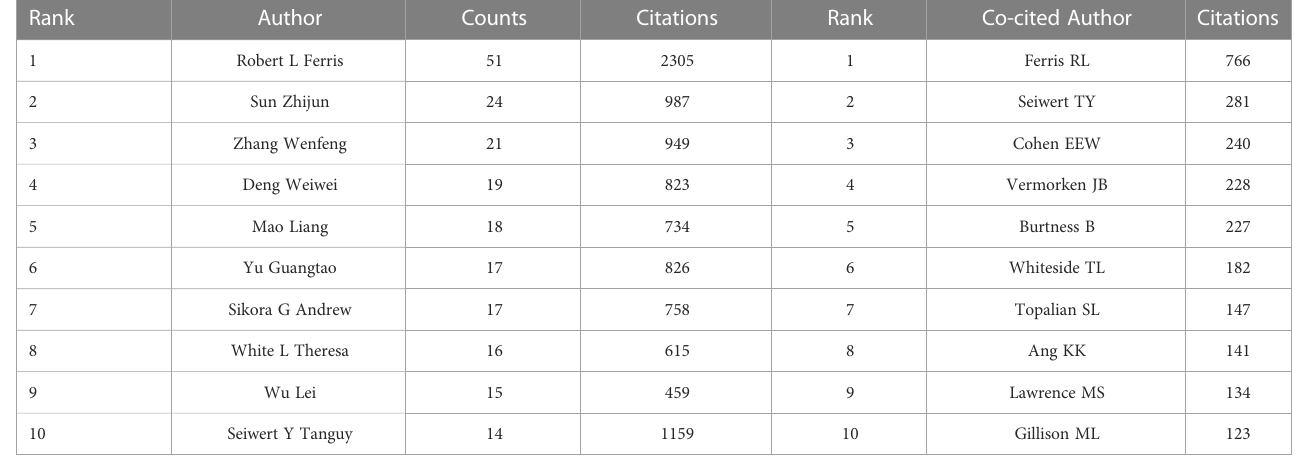
TABLE 3 Top 10 authors and co-cited authors involved in HNSCC immunotherapy research.